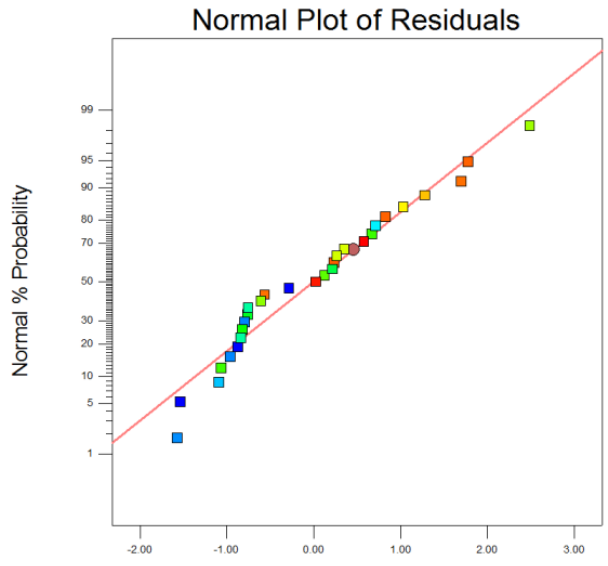
Figure 2. External studentized residuals.